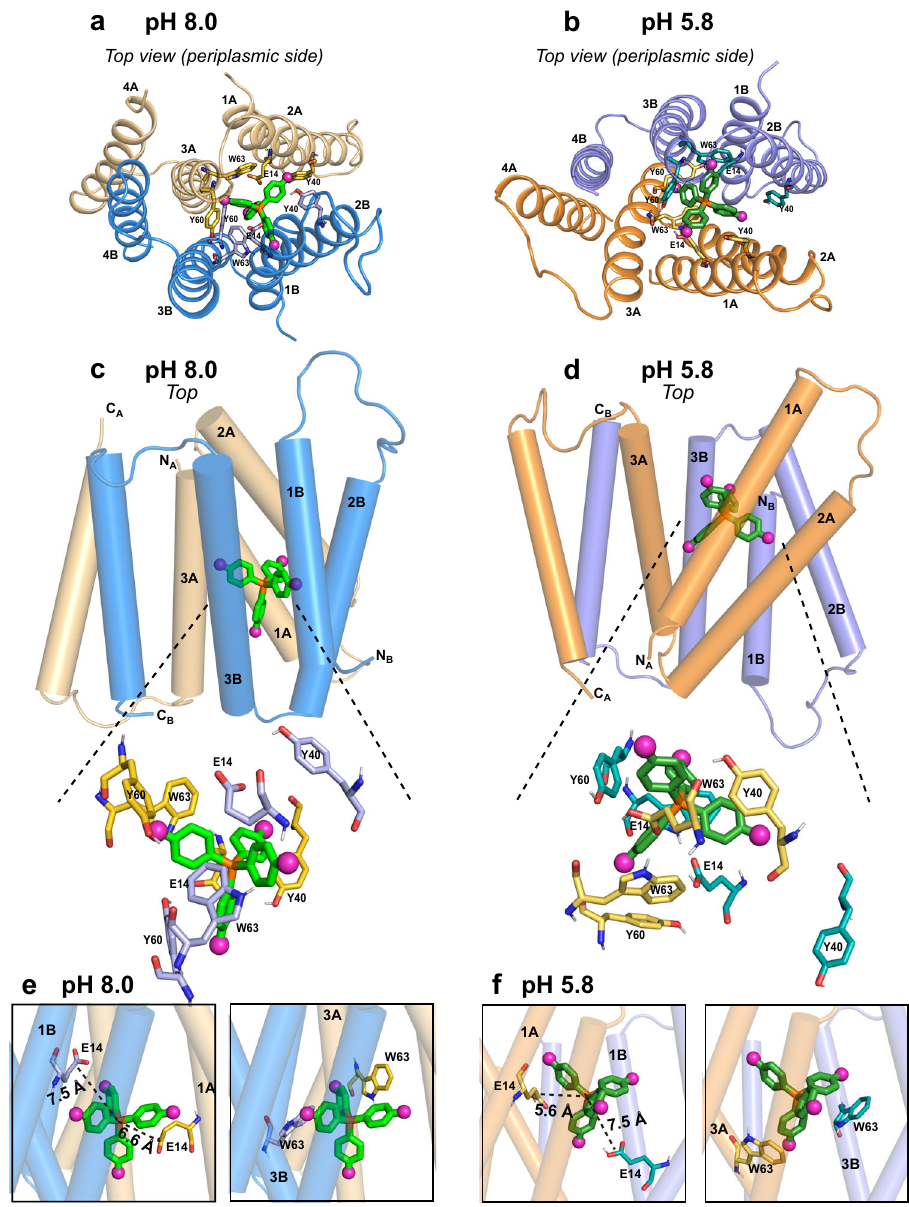
Fig. 4 Structure of the EmrE-TPP complex in DMPC bilayers at high pH (PDB: 7SFQ) and its comparison with the previously determined low-pH structure (PDB: 7JK8). a Top view of the high-pH EmrE-TPP complex structure, seen from the periplasmic side. The crucial binding-site residues E14, Y40, Y60, and W63 are shown as sticks. b Top view of the low-pH EmrE-TPP complex for comparison. Note that conformer A (beige) in the high-pH complex has changed to conformer B (purple) in the low-pH complex. This conformational change switches the designation of the two subunits between the high and low pH complexes. c Side view of the high-pH structure. d Side view of the low-pH structure. The ligand is buried deep in the high-pH complex but is more exposed to the top side in the low-pH complex. The arrangement of the TM helices differs noticeably between the two structures. e TPP + position relative to E14 and W63 in the high-pH structure. The ligand center P atom is similarly distanced from the two E14 residues. f TPP position relative to E14 and W63 in the low-pH structure. The ligand is ~2 Å closer to E14A than E14B.